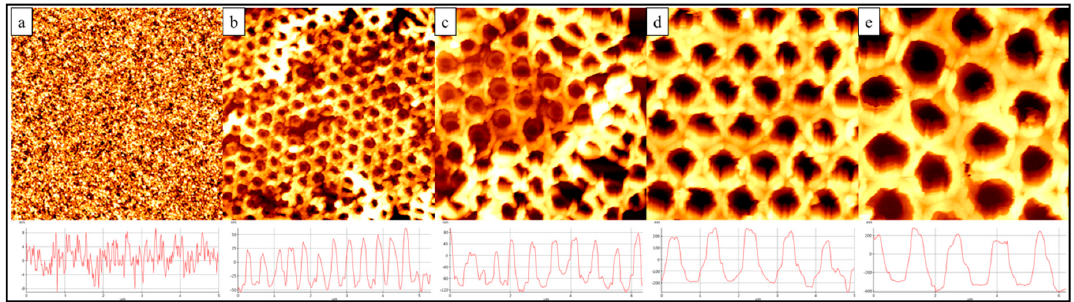
Figure 2. Atomicforce microscopy(AFM) images with line profiles of nonpatterned TiO 2 films ( a ) and PS-patterned TiO 2 films with diameters of 400 nm ( b ), 700 nm ( c ), 1000 nm ( d ) and 1300 nm ( e ).